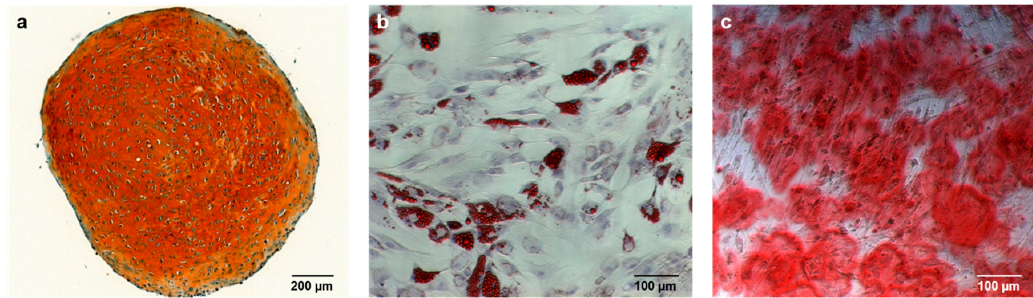
Figure 2. Representative analysis of trilineage differentiation in cells of one donor. Chondrogenic differentiation ( a ) is indicated by the orange extracellular matrix in Safranin O/Fast Green staining. The red-colored fatty vacuoles in Oilred-O staining ( b ) are correlates of adipogenic differentiation. Alizarin red stains extracellular calcium deposited by osteogenically differentiated mesenchymal stem cells (MSC) red ( c ).